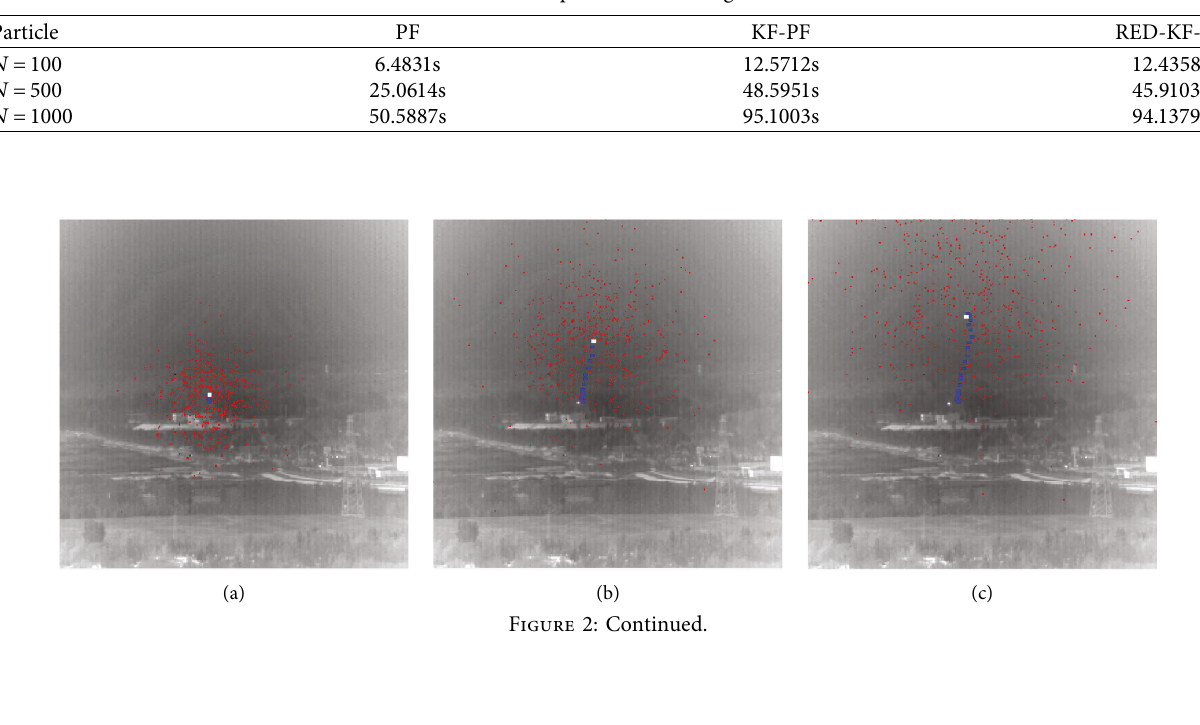
Table 2: Comparison of running time.